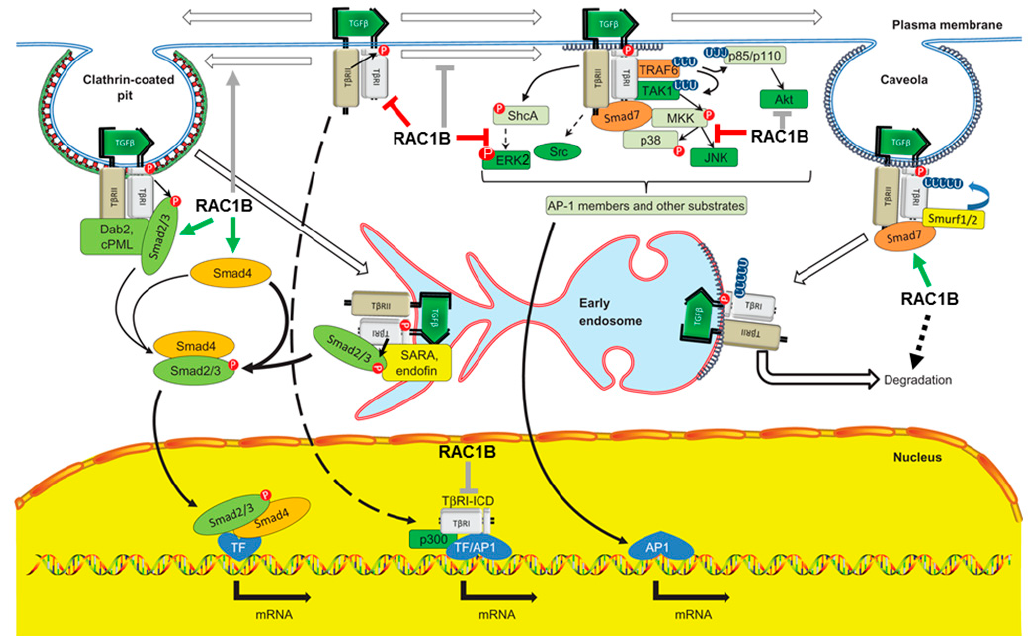
Figure 2. Schematic illustration of signaling via TGF β receptors initiated at different intracellular locations and sites of inhibition by RAC1B. TGF β binding to its receptors on the cell surface activates both Smad-mediated and non-Smad signal transduction pathways. Receptors are distributed between different compartments/microdomains of the plasma membrane. In the clathrin-coated pits (left-hand side) activated TGF β receptors bind and phosphorylate SMAD2/3, initiating the canonical Smad pathway. In the lipid rafts/caveolae of the plasma membrane (right-hand side) the receptors preferentially associate with SMAD7. This inhibitory Smad negatively regulates Smad-mediated signaling by competing with SMAD2/3 for interaction with ALK5/T β RI and recruits the E3 ubiquitin-protein ligases Smurf1 and Smurf2, which direct ubiquitin-dependent degradation of the TGF β receptor complex (right-hand side). SMAD7 can also function as an adaptor protein, facilitating the activation of non-Smad signaling pathways (center). In early endosomes (EEs) Smad-mediated signaling is further enhanced by accessory proteins (SARA and endofin). In the nucleus, the intracellular domain of ALK5 (T β RI-ICD) can act as a transcription factor to regulate the expression of genes like SNAI1 and MMP2 . Stimulatory interactions of RAC1B are denoted by green arrows, inhibitory ones by red lines. Gray arrows or lines indicate the still hypothetical nature of the interactions. Adapted from [31], modified.